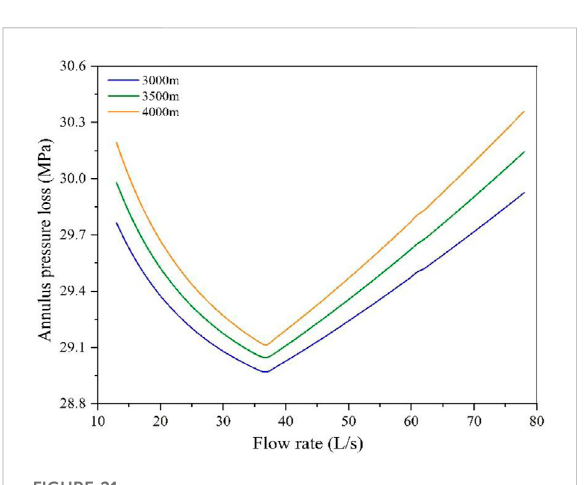
FIGURE 21 Effect of horizontal section length on pressure